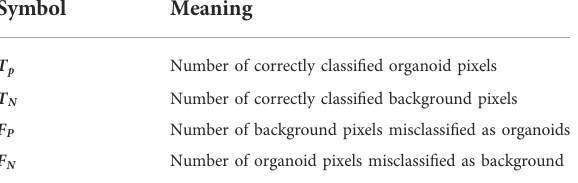
TABLE 1 Meaning of symbols in formula